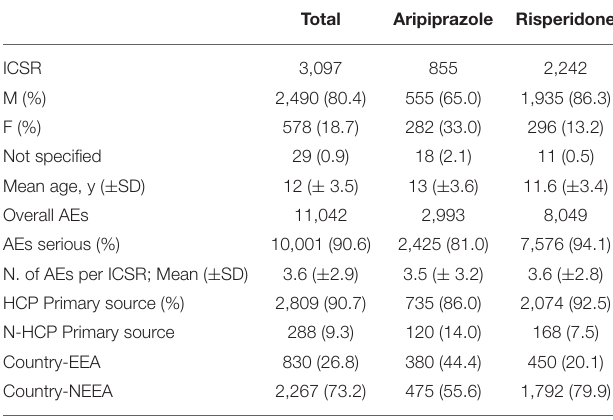
TABLE 1 | Demographic characteristics and distribution for sex, age, seriousness, the type of reporter, country, involving aripiprazole, and risperidone recognized in the EudraVigilance spontaneous reporting system from 2016 to 2018 in pediatric population (3–17 years).